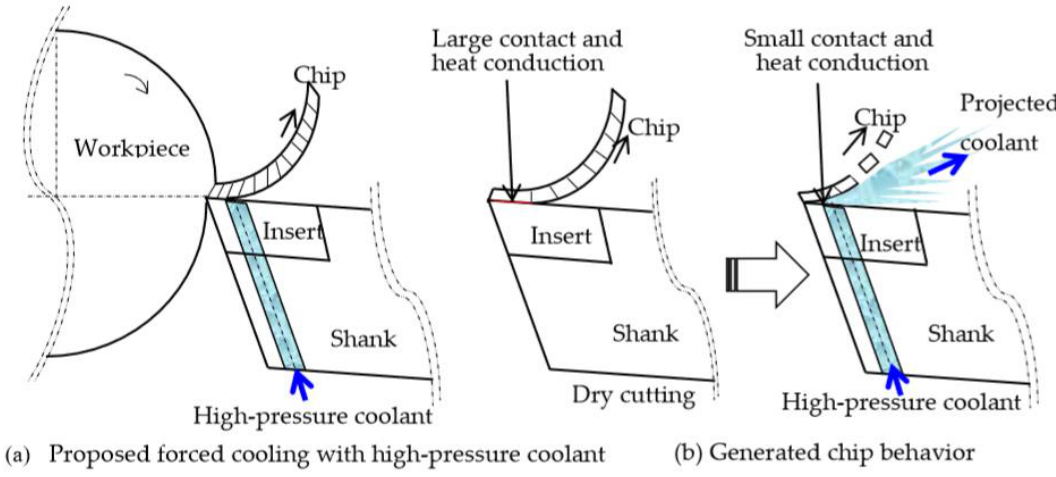
Figure 1. Schematics of the proposed forced cooling method with high-pressure coolant.